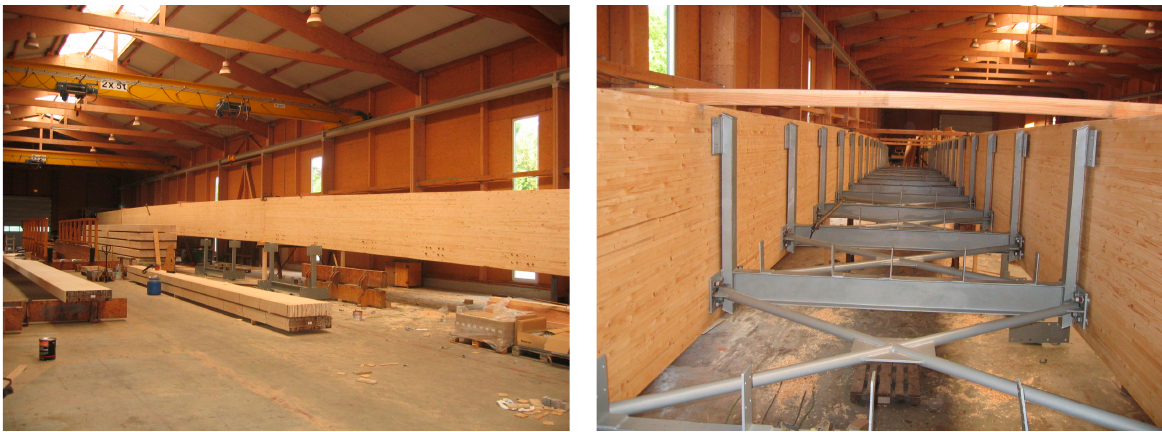
Figure 1. Environmental ‐ friendly glued ‐ laminated wood used for construction of the footbridge’s main girders and the deck (Photo credit: Schmees & Lühn Holz ‐ und Stahlingenieurbau GmbH & Co. KG and Mosty ‐ Wroc ł aw Design & Research Office). main girders and the deck (Photo credit: Schmees & Lühn Holz- und Stahlingenieurbau GmbH & Co. KG and Mosty-Wrocław Design & Research